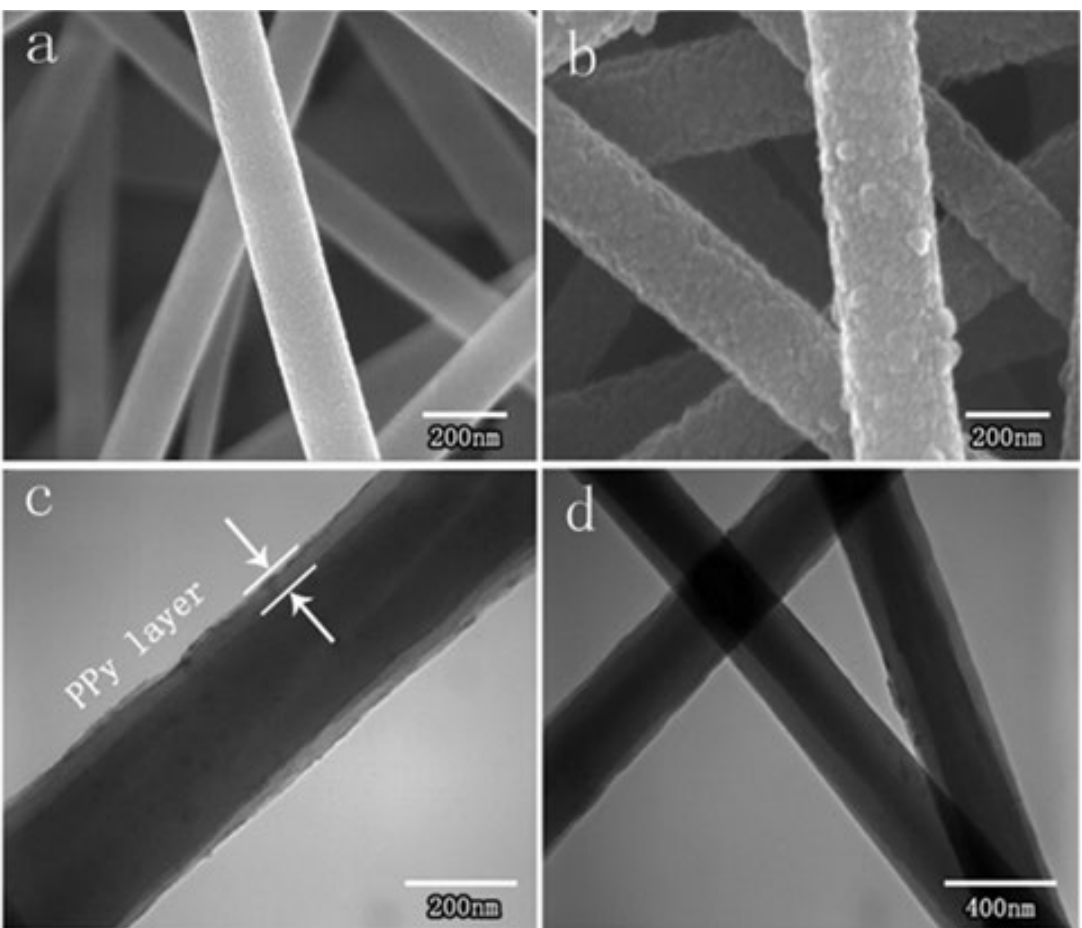
Figure 5. ( a ) Pure PAN nanofiber; ( b ) PAN/Ppy nanofiber; ( c ) PAN/Ppy nanofiber; ( d ) SEM and TEM image of PAN/Ppy nanofiber membrane. Reprinted with permission from ref. [50] . Copyright 2013 Elsevier.